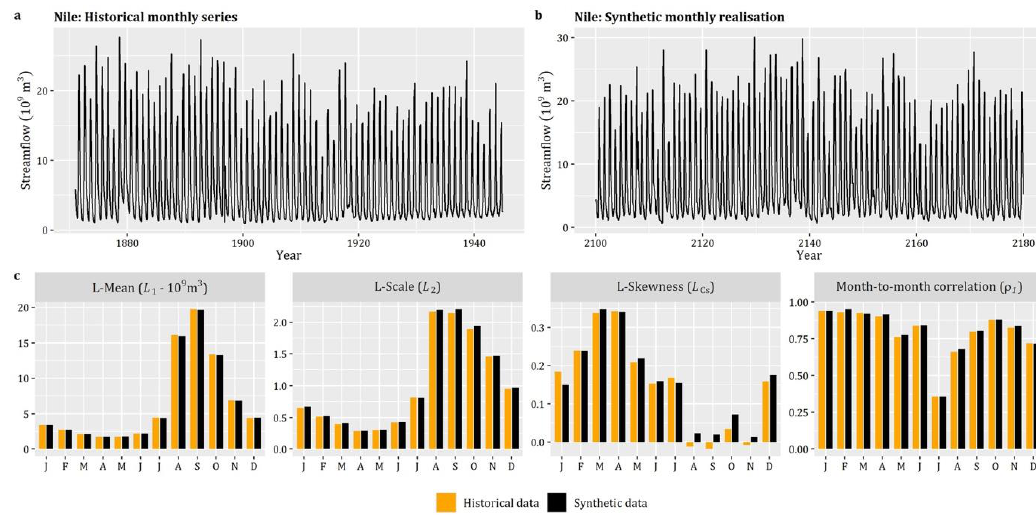
Figure 11. ( a ) Historical Nile monthly streamflow series (March 1870 to December 1945); and ( b ) synthetically generated time series using the anySim package (randomly selected window of 80 years). Monthly-based comparison of historical and simulated (bottom row ( c )) L-mean, L-scale, and L-skewness, as well as lag-1 month-to-month correlations coefficients.